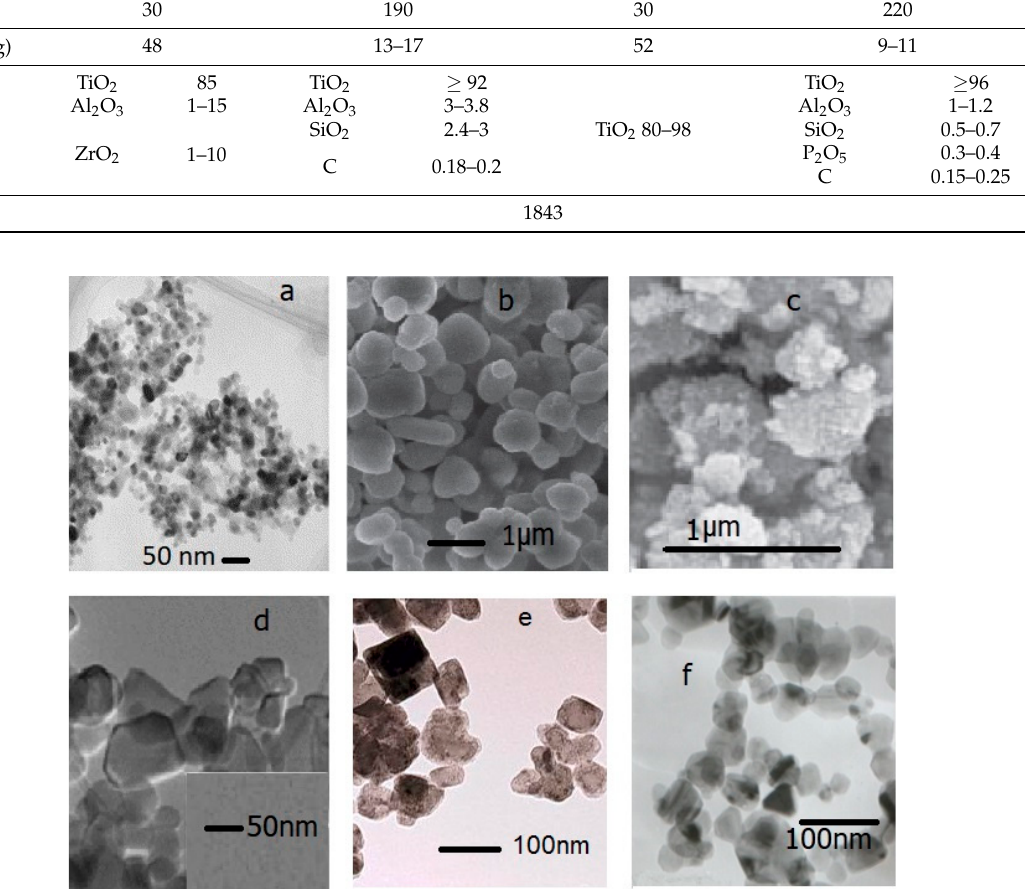
Figure 1. TEM micrographs of raw materials: ( a ) TiO 2 rutile nm [26], ( b ) TiO 2 rutile µm [27], ( c ) TiO